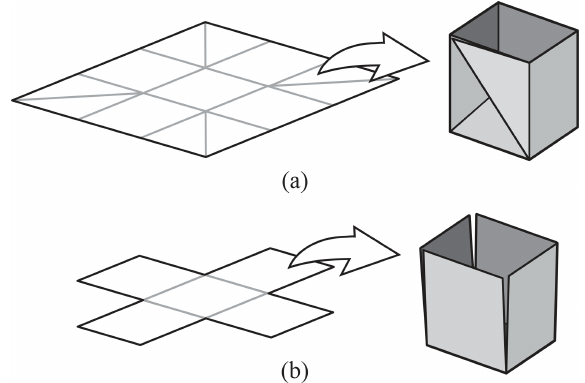
Figure 18. Both fold states shown in (a) and (b) have a similar overall shape when folded, but the fold state in (a) has a water-tight seam because the surface is unbroken.